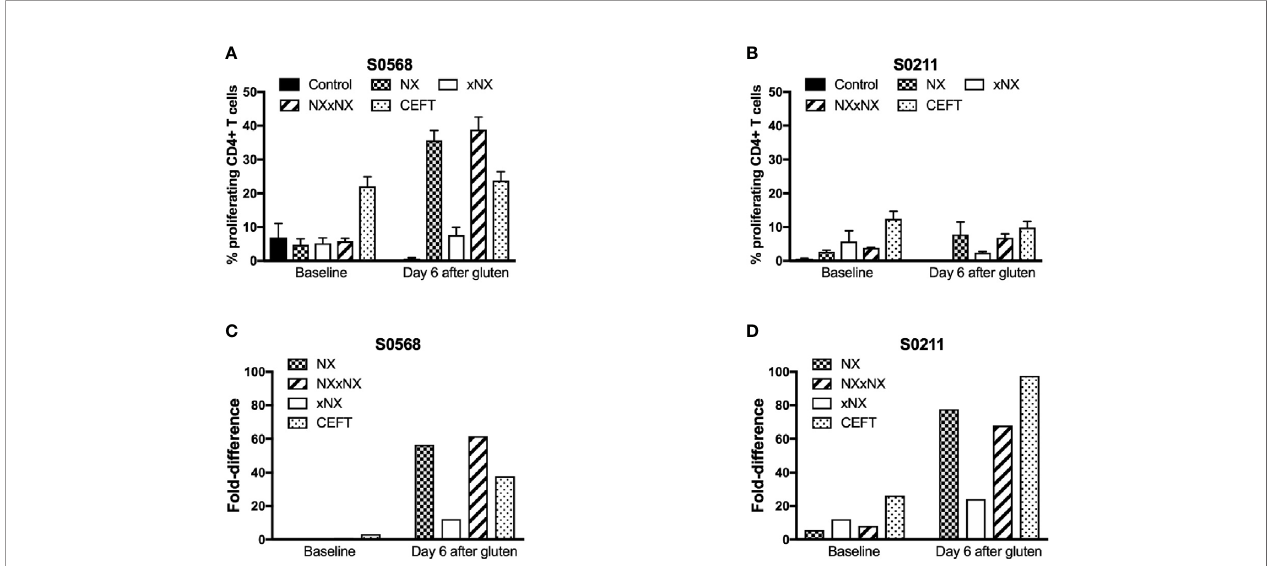
FIGURE 2 | CD4+ T cell proliferation assessed by CTV-dilution in fresh PBMC from two HLA-DQ2.5+ CD patients incubated for 8 days with peptide pools containing Nexvax2 peptides (NX), non Nexvax2 peptides (xNX) or both, or CEFT positive control peptides. Mean (SEM) percent proliferating CD4+ T cells (A, B) and mean fold-difference in proliferation compared to control (C, D) is shown for PBMC incubated with peptide mixes, data represent mean of